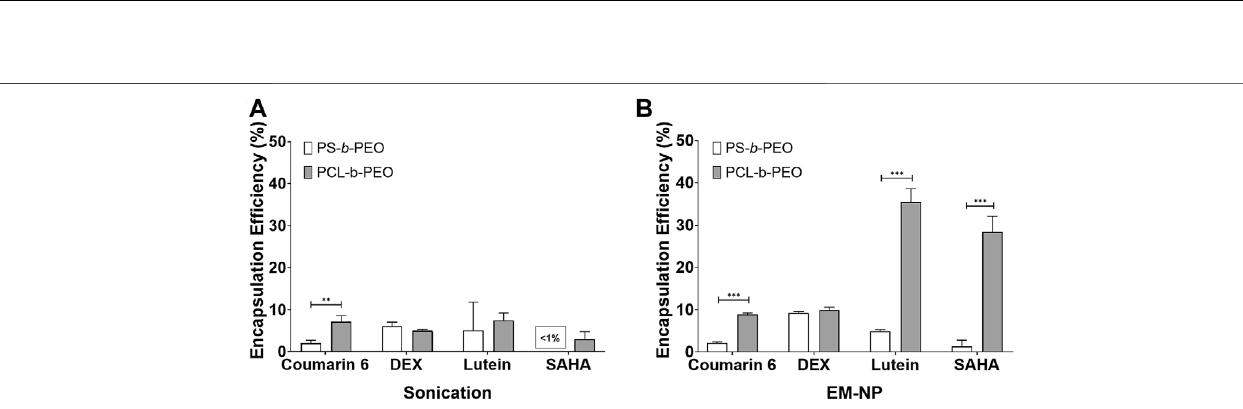
FIGURE 5 | Encapsulation ef fi ciency (%) of PS- b -PEO, and PCL- b -PEO NPs for Coumarin 6, DEX, Lutein, and SAHA synthesized via (A) Sonication, and (B) EM- NP. Error bars (cid:1) standard deviation from mean. N (cid:1) 3 for each data point. Statistically difference between PS- b -PEO and PCL- b -PEO NPs indicated by ** p < 0.001 or *** p <